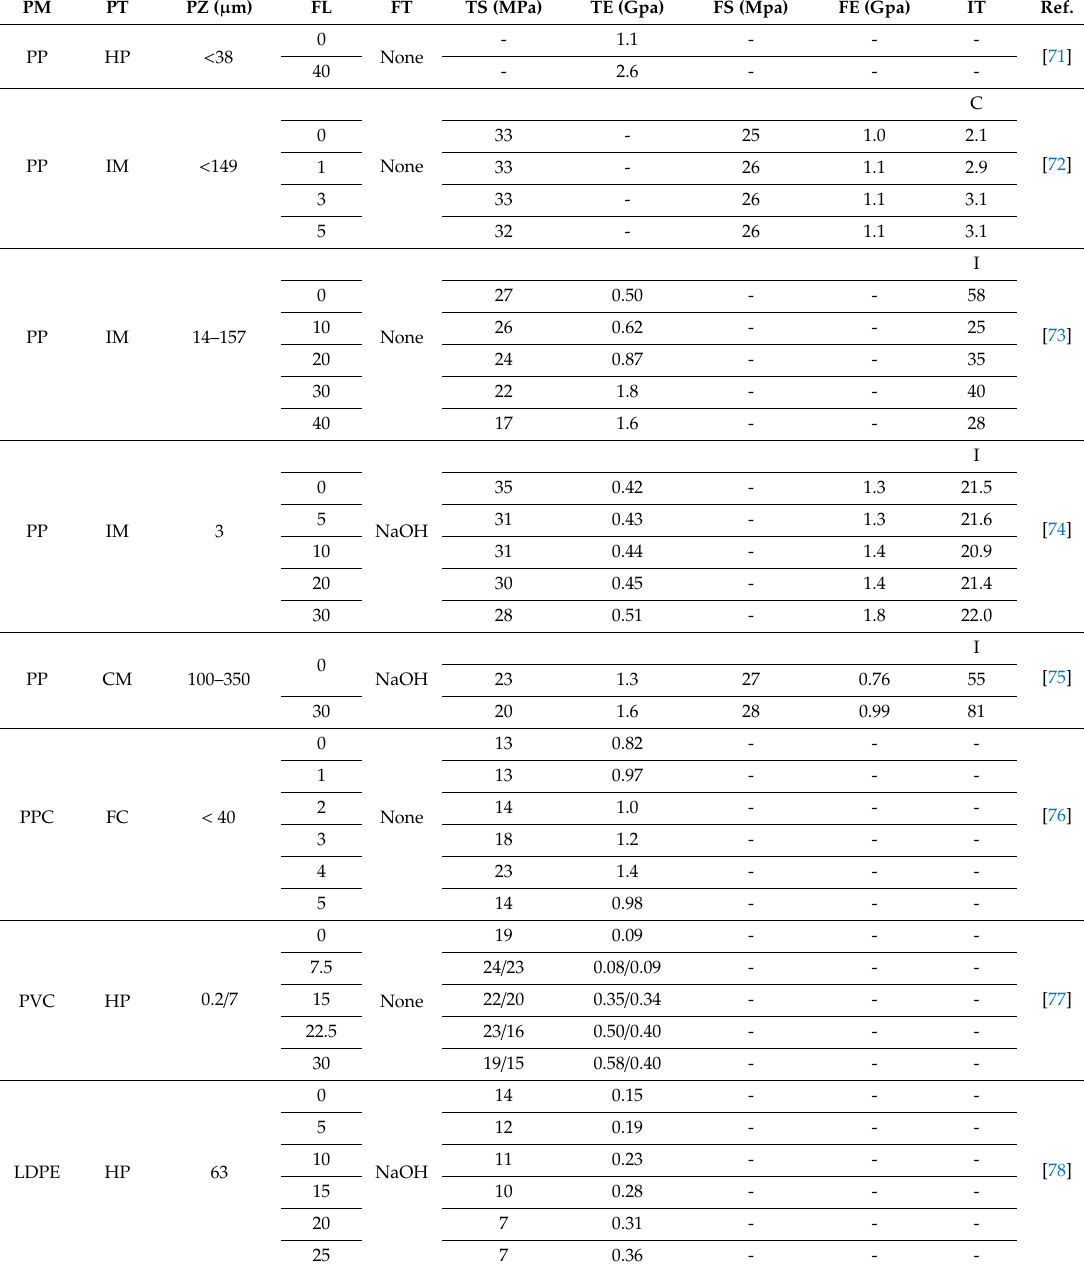
Table 5. Summary of thermoplastic polymers containing eggshell